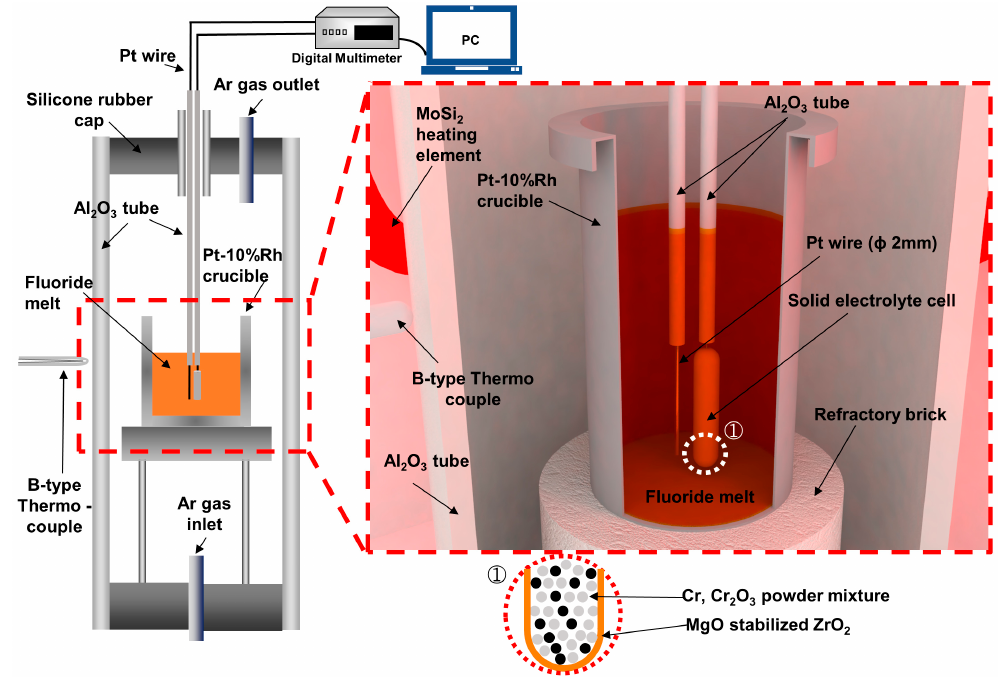
Figure 1. Schematic of the experimental apparatus used for measurement of the electromotive force (EMF) potential. The small inset in the dashed circle( ① ) is a cross-sectional image of a reference electrode cell.